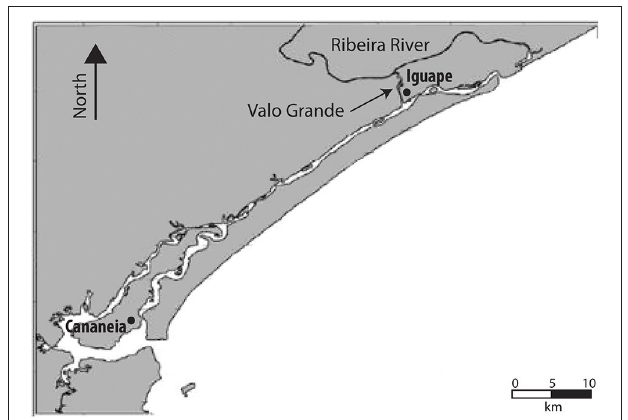
FIGURE 1 | Map of the Cananeia-Iguapé System.